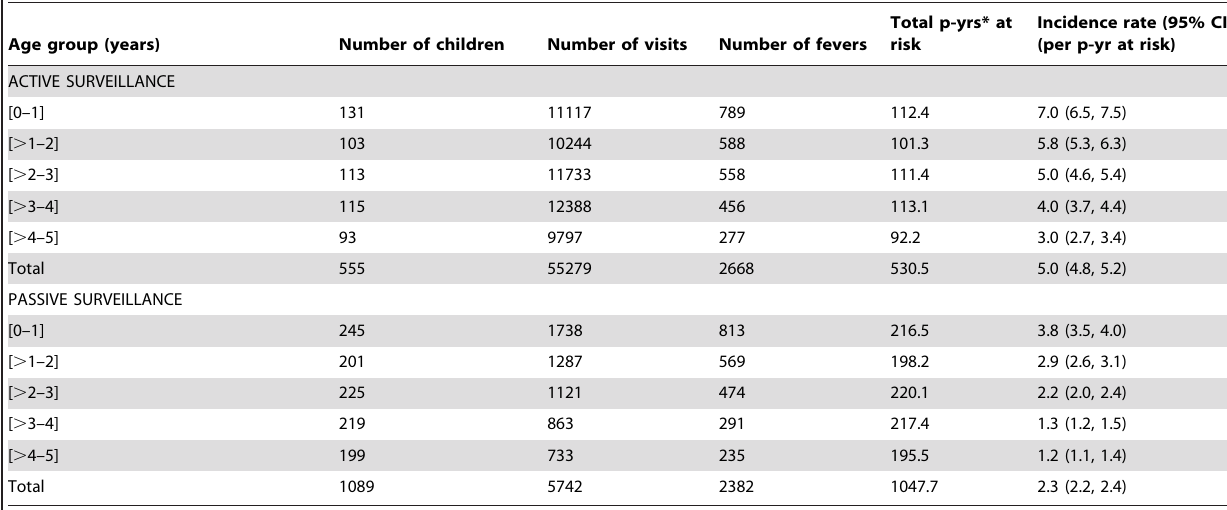
Table 2. Age-specific incidence of fever over one year follow-up.